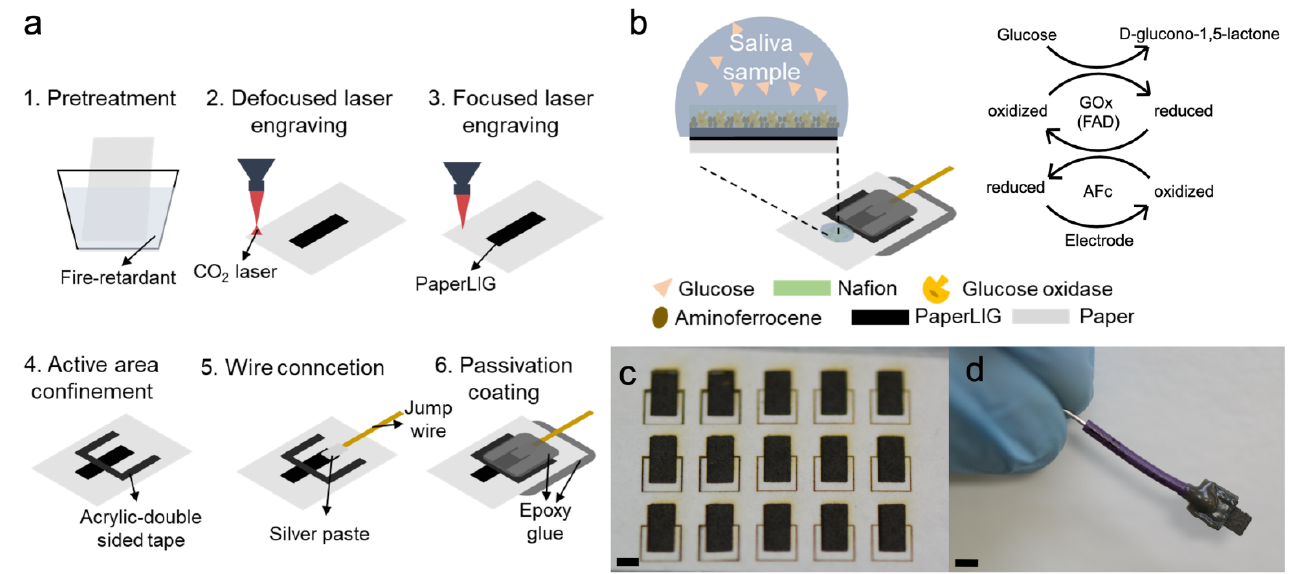
Figure 1. ( a ) Illustration of the fabrication process of PaperLIG electrode. ( b ) The structure of the developed PaperLIG-based glucose biosensor. The sensing mechanism of the glucose biosensor is also shown on the right. ( c ) Mass production of PaperLIG material. Scale: 3 mm. ( d ) The fabricated PaperLIG electrode. Scale: 3 mm.